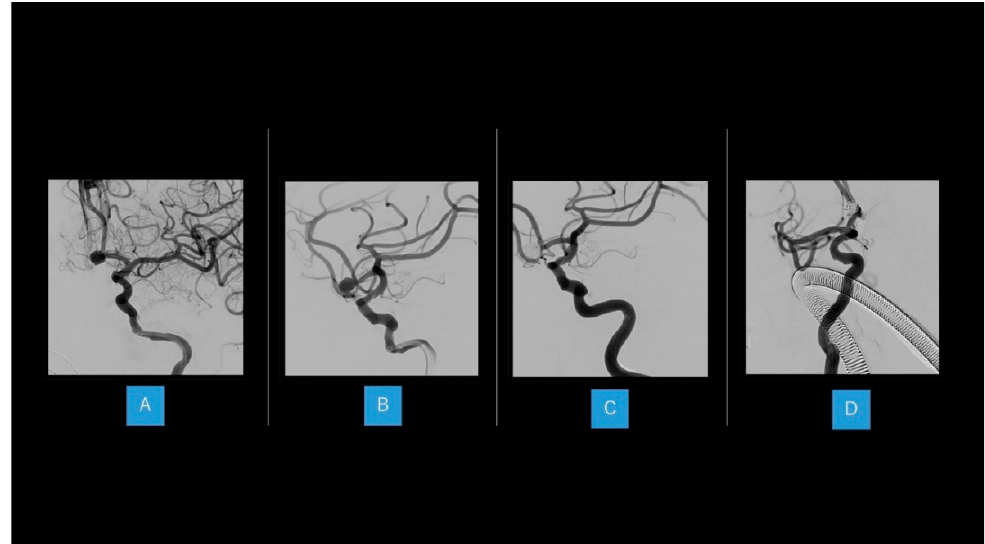
Figure 2. Interventional radiology therapy in our case ( A , B ) A 7 mm aneurysm is seen at the anterior communicating artery (AcomA). ( C , D ) Five coils are applied to the dome of the AcomA aneurysm under general anesthesia.